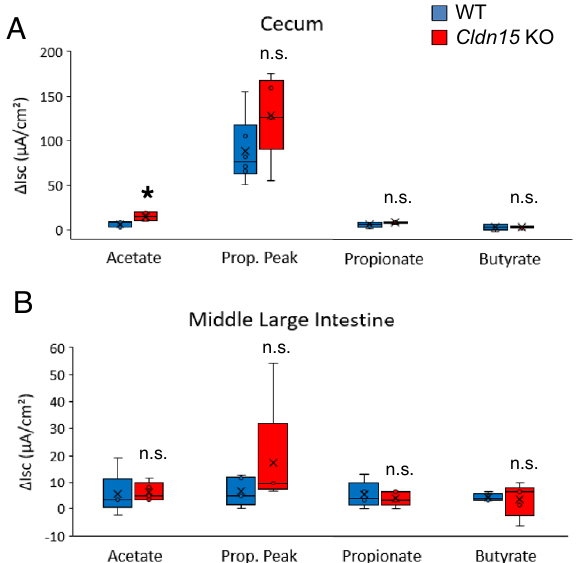
Figure 10. Short chain fatty acid-induced short-circuit current in the cecum and large intestine. Short-circuit current increases were measured in Ussing chambers after addition of 10 mM of acetate, propionate, or butyrate to the mucosal (M side) of ( A ) the cecum and ( B ) the middle large intestine of Cldn15 KO mice. The box plots represent the minimum, first quartile, median, third quartile, and maximum values, the mean is marked with an X, n = 5 and 5–6, KO and WT, respectively. Statistical significance from left to right: ( A ) *P = 0.004; n.s. P = 0.177; n.s. P = 0.126; n.s. P = 0.931; ( B ) n.s. P = 0.548; n.s. P = 0.421; n.s. P = 0.690; n.s. P = 0.841, Mann–Whitney U test, Cldn15 KO vs. WT. Please see supplementary table 5 for data